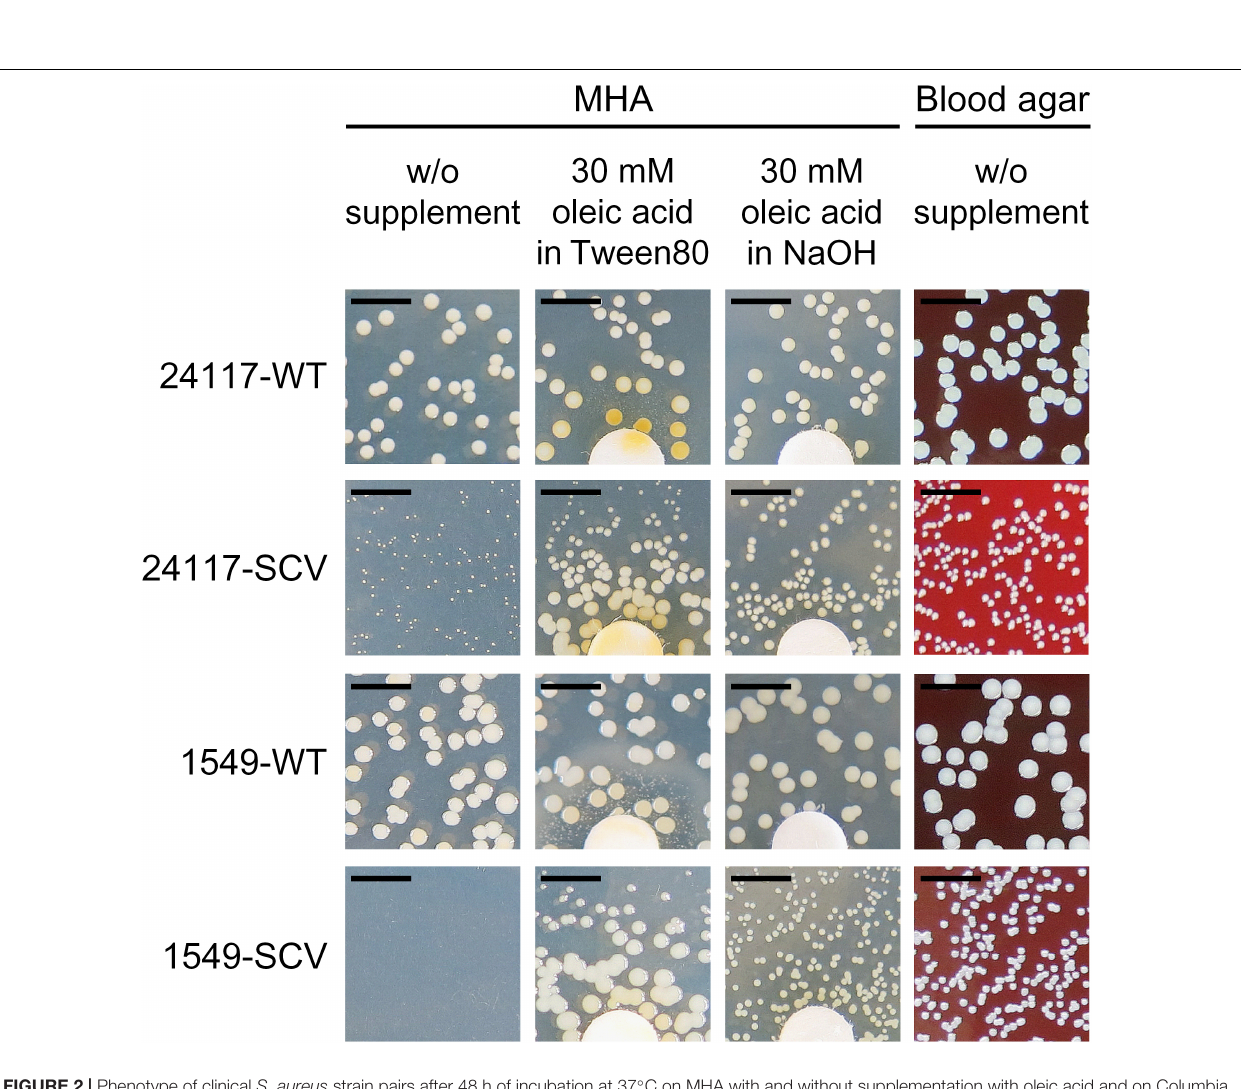
Frontiers in Microbiology |